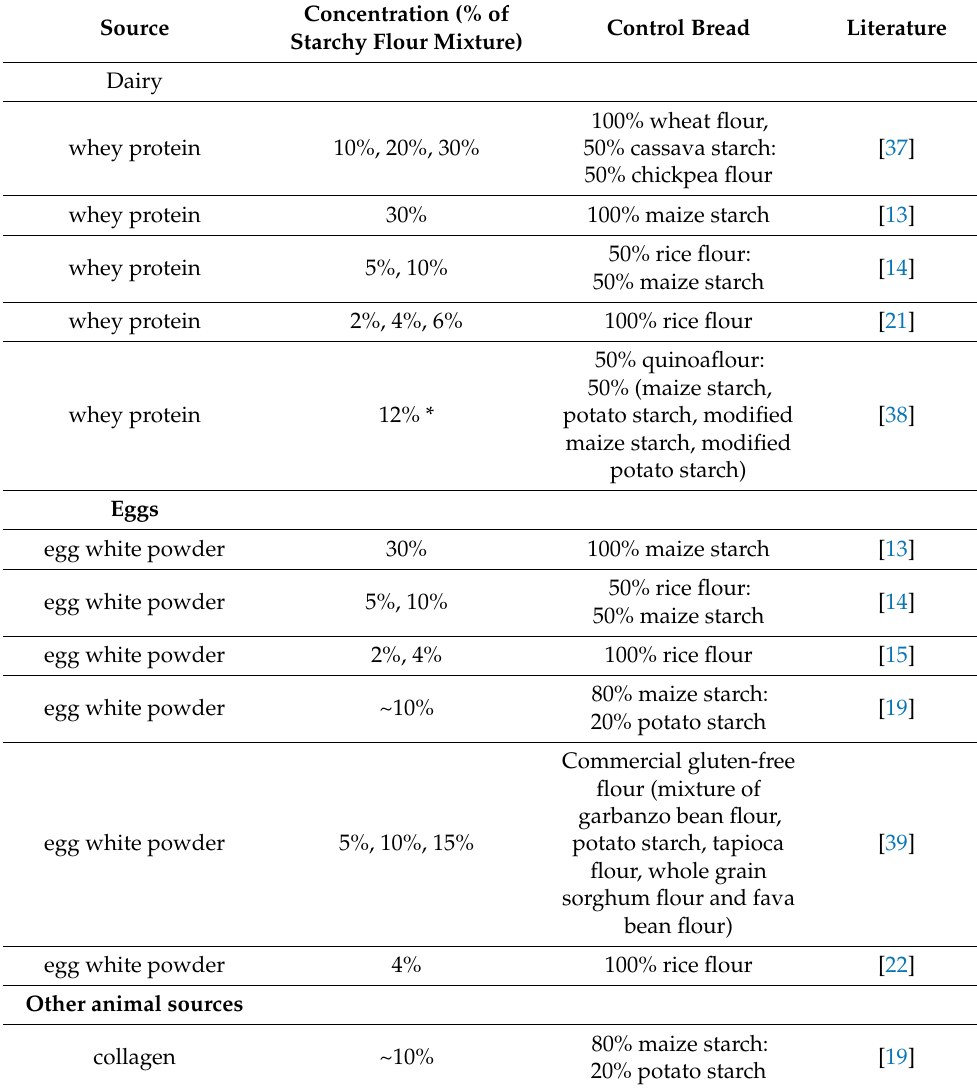
Table 2. Different high protein sources of animal origin in recent published literature to improve gluten-free